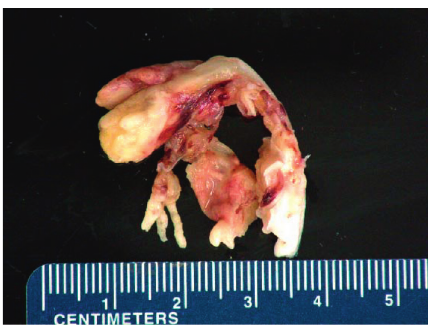
Figure 2: Gross pathology of the mitral valve with a left atrial polypoid mass measuring 4.0 cm ×